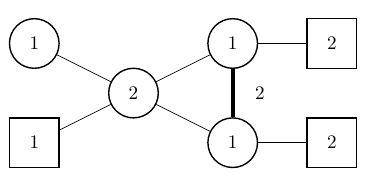
Figure 22 . The 3d mirror of the theories T and T ∨ in figure